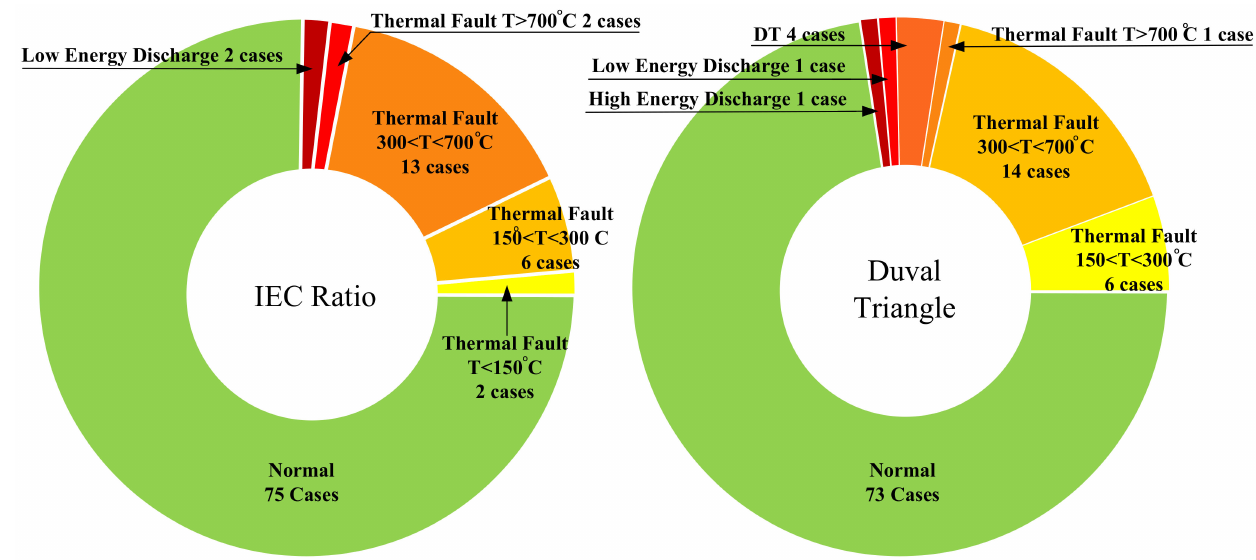
Figure 13. Fault types analyzed by using a fuzzy logic system with IEC ratio and Duval triangle methods.